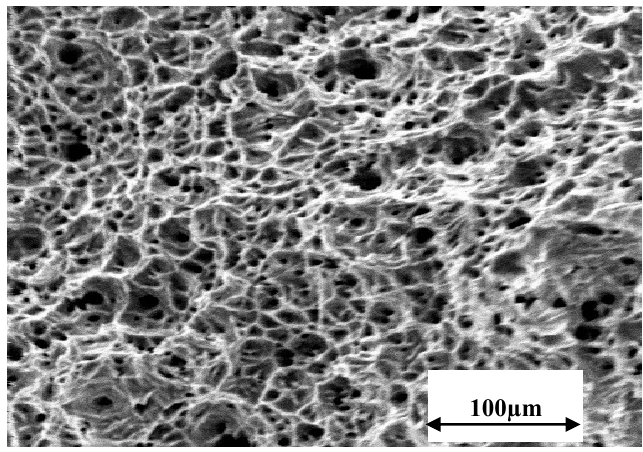
Figure 4. A representative SEM fractograph showing purely ductile